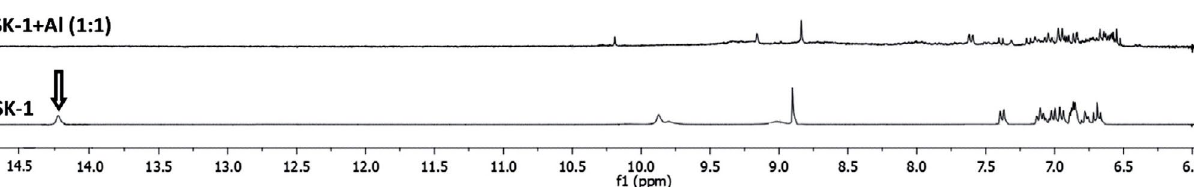
Fig. 7. 1 H NMR spectra in DMSO- d 6 of SK-1 with (1.0 equiv of Al 3+ ) and without Al 3+